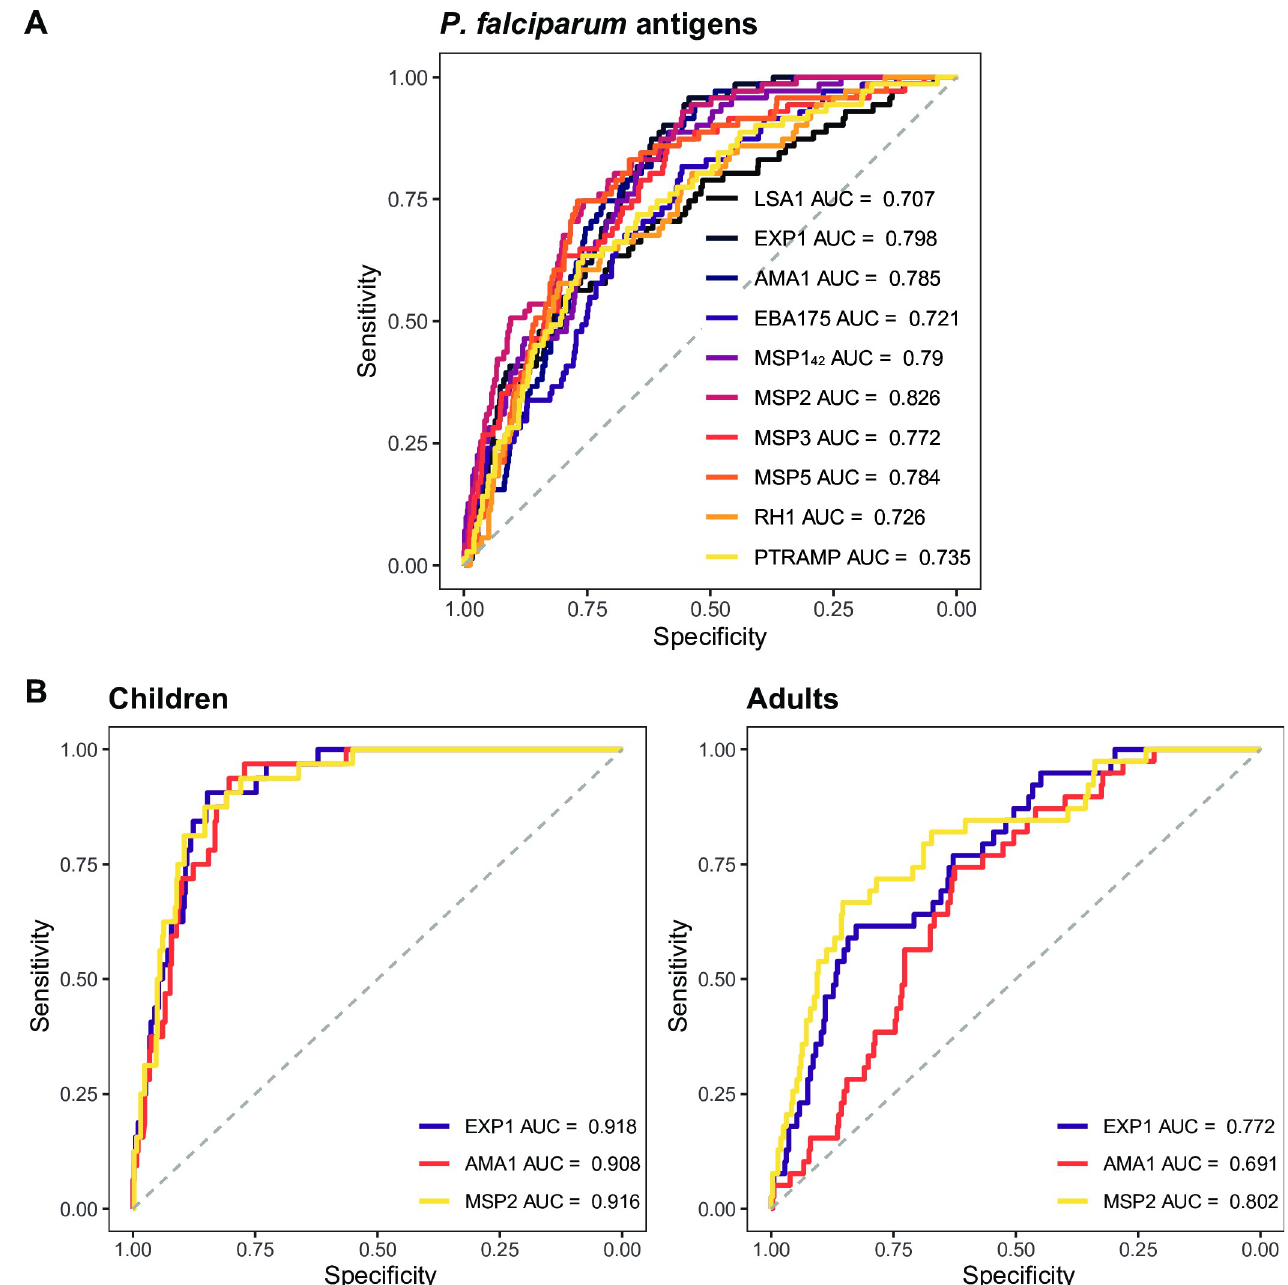
Fig 6. Receiver operating characteristic curves and their corresponding areas under the curve from the best performing IgG responses in detecting current Plasmodium falciparum infection. A. IgG responses (log 10 -transformed median fluorescence intensity [MFI] levels) against LSA1, EXP1, AMA1, EBA175, MSP1 42 , MSP2, MSP3, MSP5, Rh1 and PTRAMP in serum samples from 715 endemic individuals and 50 Spanish donors were used as predictor variables and qPCR results as response variable. B. IgG responses (log 10 -transformed MFI levels) against EXP1, AMA1 and MSP2 in serum samples from children (N = 363) and adults (N = 352) were used as predictor variables and qPCR results were used as response variable. In each age group, antibody levels in samples from the 50 Spanish donors were used as negative controls. AUC: Area Under the